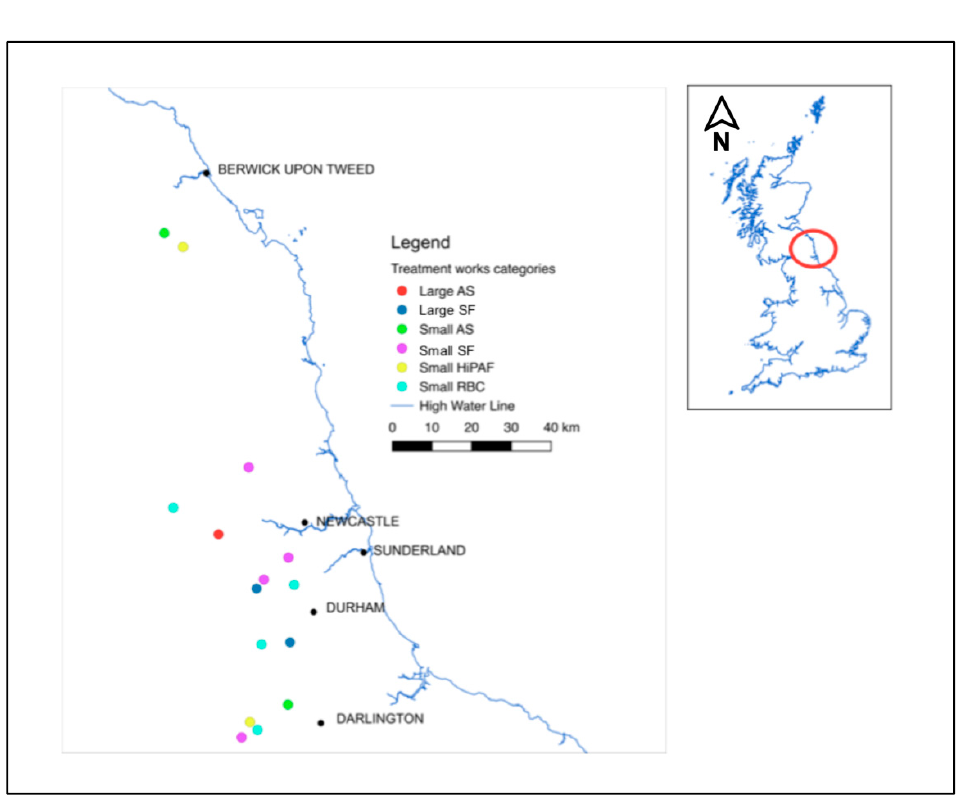
Table A3. Confusion matrix for gradient boosting machine when predicting the reliability of small WWTPs.